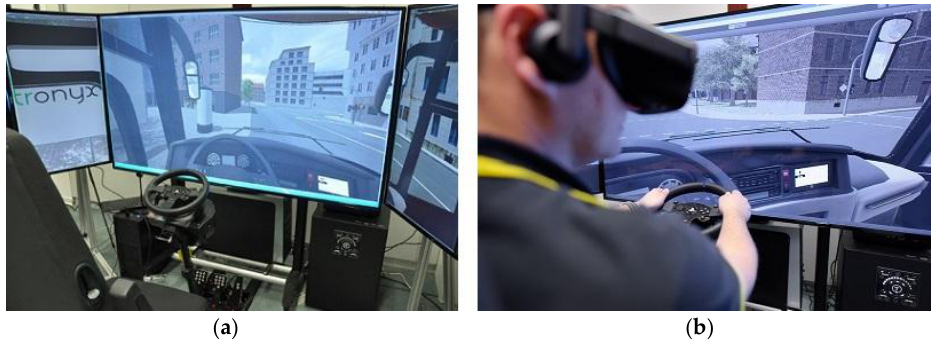
Figure 2. A driving simulator developed within the project inTraSim: ( a ) The hardware equipment of the developed driving simulator; ( b ) A test driver performing a turn-right maneuver. As shown in Figure 2a, the developed driving simulator has a real bus driving seat and is equipped with three front screens to cover a horizontal field of view of 120 degrees. Figure 2b shows a bus test driver that intends to turn right with the help of a blind spot assistance system. Other driver assistance systems can be introduced to bus drivers using this driving simulator, such as cruise control and lane departure